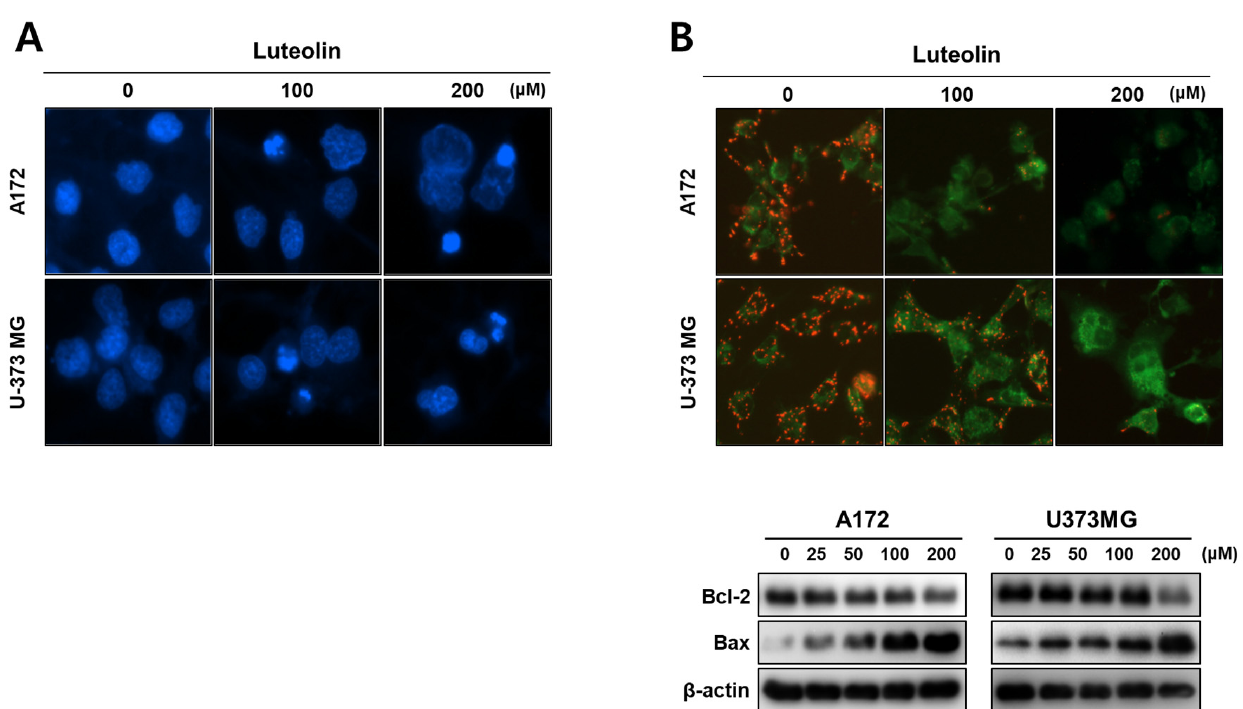
Figure 2. Effects of luteolin on the nucleus and mitochondria of GBM cells. ( A ) The A172 and U-373MG cells treated with luteolin (100 and 200 μ M for 24 h) showed nuclear condensation and fragmentation. The nuclear morphology of the GBM cells was confirmed using Hoechst staining. ( B ) Mitochondrial membrane potential was determined by JC-1 staining (upper), and Bcl-2 and Bax expressions were determined using Western blot assay. The A172 and U-373MG cells were treated with 100 and 200 µ M luteolin. In both cell lines, the JC aggregate (red fluorescence intensity) was reduced by luteolin. In the luteolin-treated cells, Bcl-2 was decreased and bax was increased in a dose-dependent manner.